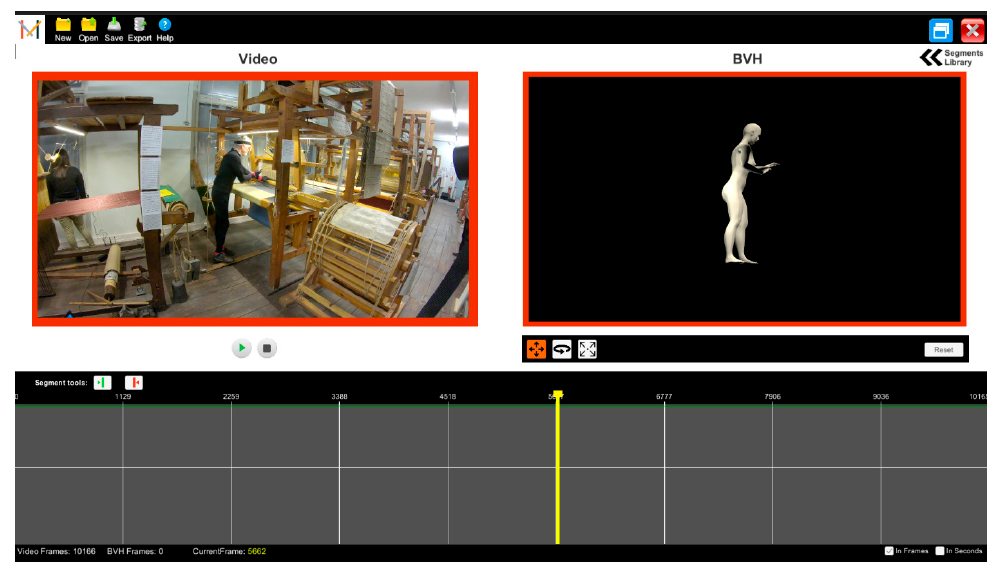
Figure 11. Previewing animation files by retargeting motion to avatars.